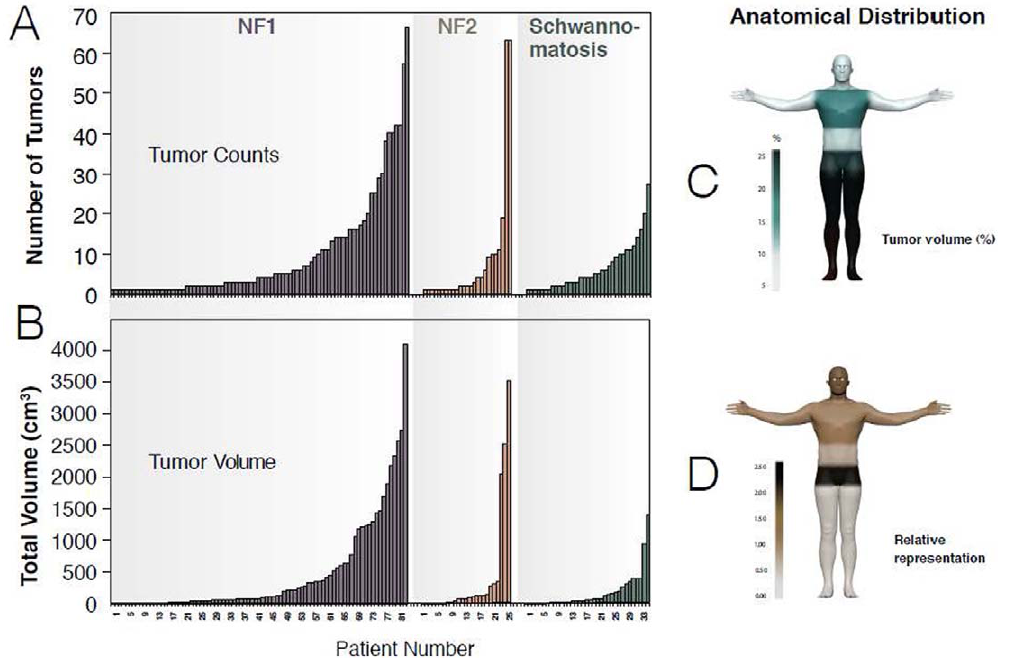
Figure 2 . Number, volume, and anatomic distribution of internal nerve sheath tumors . Waterfall plot of tumor count (panel A) and tumor volume (Panel B) in 145 patients with at least one internal tumor. Anatomic distribution of relative tumor volume given as a percentage of whole- body volume (Panel C) and corrected for volume per body part (Panel D).